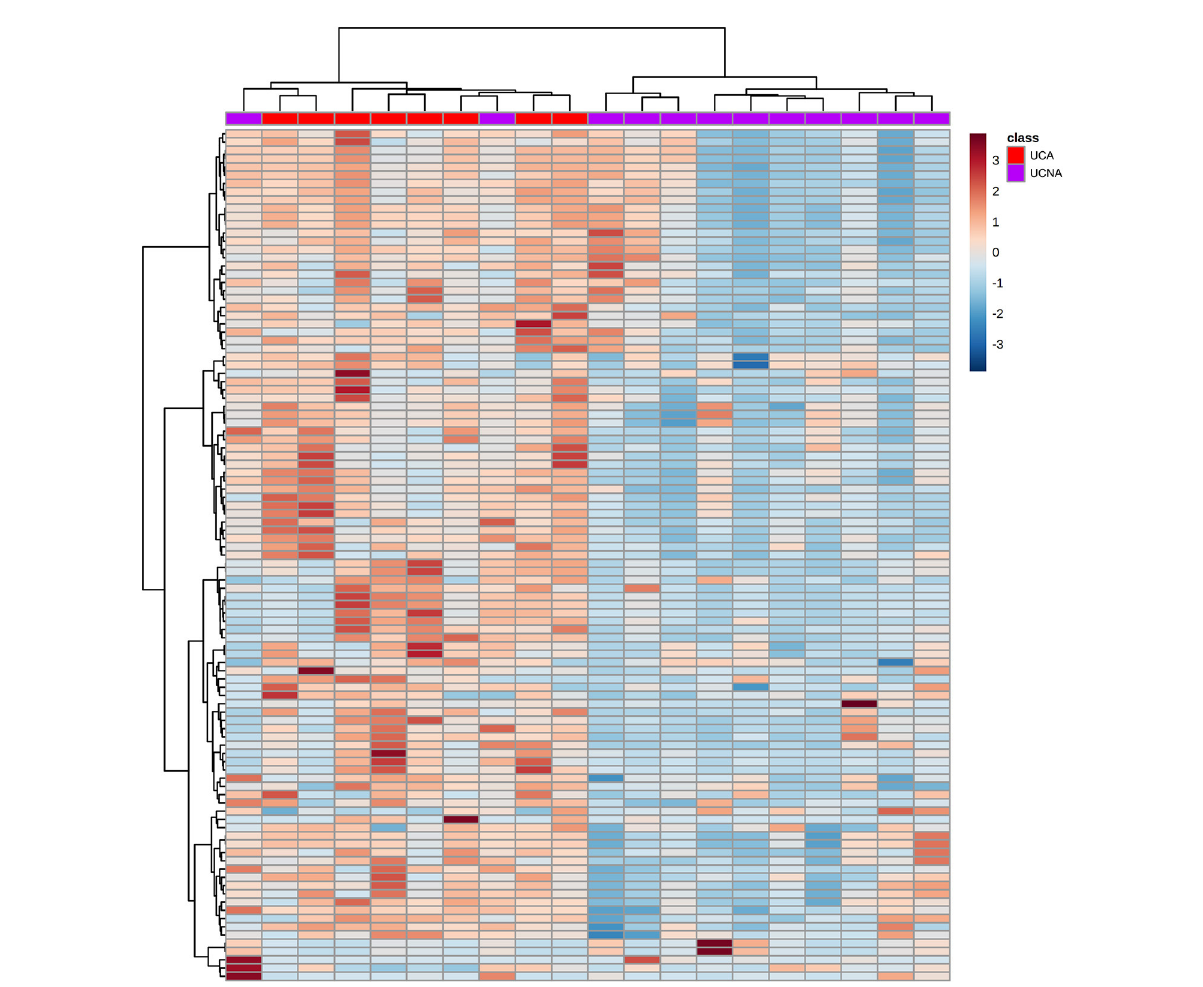
FIGURE3 Hierarchical clustering analysis heatmap of the UCA (red) and UCNA (purple) patients (in columns) built using the 103 significantly different signals between the groups (in columns). Samples and metabolites were clustered according to their similarity. Red and blue cells represent an increase or decrease in the abundance of a given metabolite.